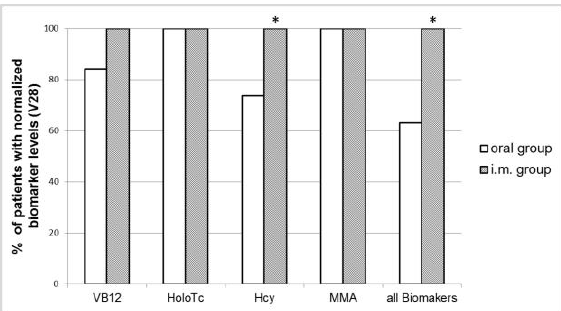
Figure 2: Proportion of patients with normalised VB12-associated biomarkers after 28 days of treatment administered by the oral (n = 19; white bar) or IM route (n = 18; grey bar). * indicates significant difference (p< 0.05). Hcy = homocysteine; HoloTc = holotrans- cobalamin; MMA = methylmalonic acid; VB12 = vitamin B